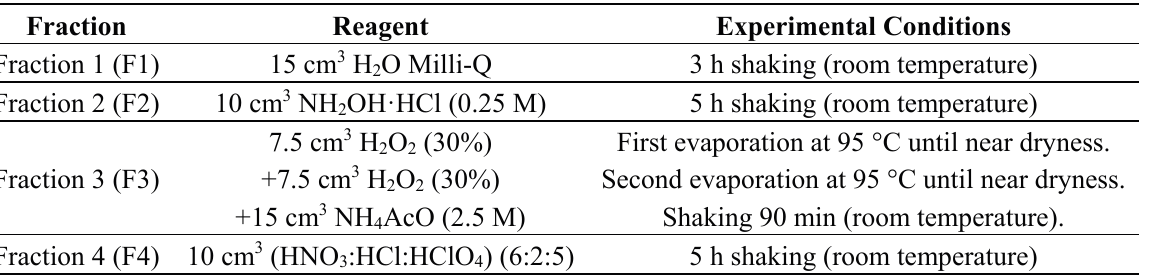
Table 1. Fractionation scheme according to